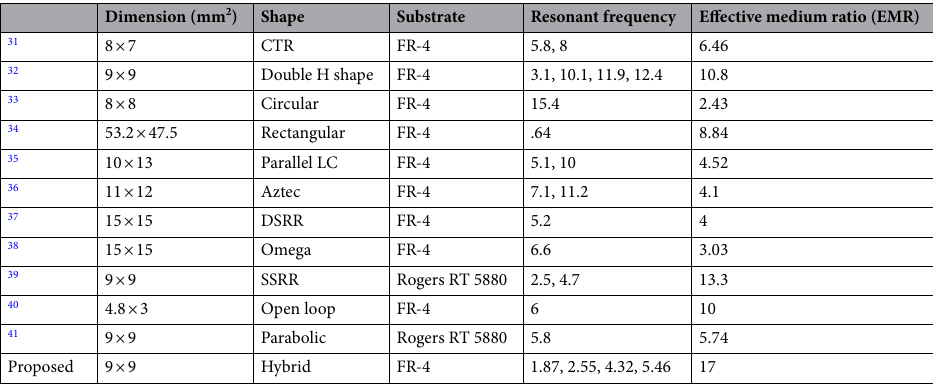
Table 4. Comparison specification with different established metamaterial unit